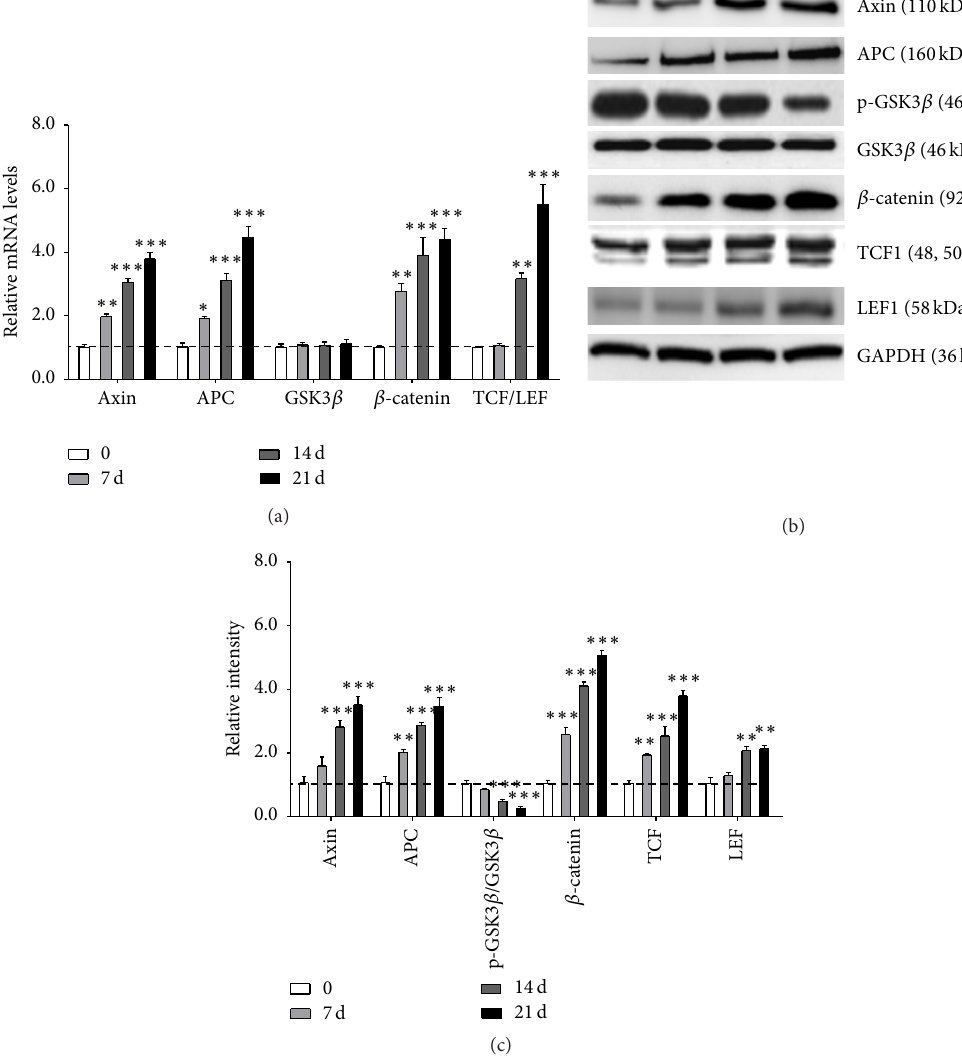
Figure 6: ET-1 promoted differentiation of PDLSCs through Wnt/ 𝛽 -catenin pathway. Upregulation of Axin, APC, 𝛽 -catenin, and TCF/LEF mRNA levels was observed (a). Western Blot analysis indicated that exposure of the cells to ET-1 effectively increased the levels of Axin, APC, 𝛽 -catenin, TCF, and LEF, whereas it downregulated the phosphor-GSK3 𝛽 ((b) and (c)). Each bar represents the mean ± standard deviation ( 𝑛 = 3 ). ∗ 𝑃 < 0.05 ; ∗∗ 𝑃 < 0.01 ; ∗∗∗ 𝑃 < 0.001 .